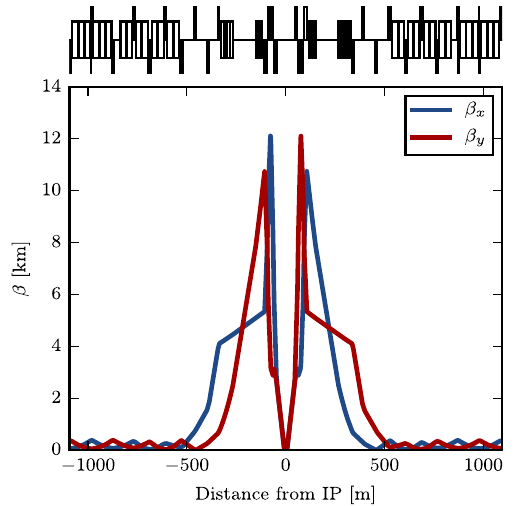
(bottom).FIG. 2. β functions of the scaled LHC lattice with L (cid:2) ¼ 46 m for β (cid:2) ¼ 0 . 8 m. The β function in the dispersion suppressors are scaled as well and will be adapted to the arc